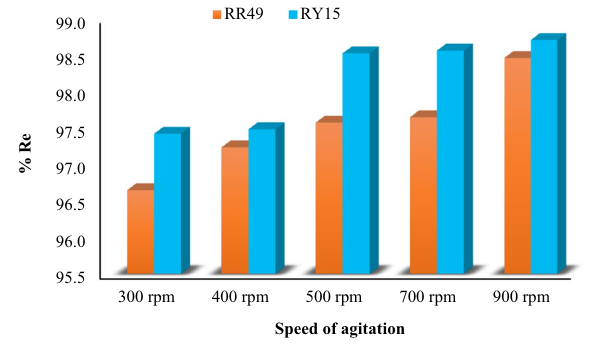
96.597.097.598.098.5